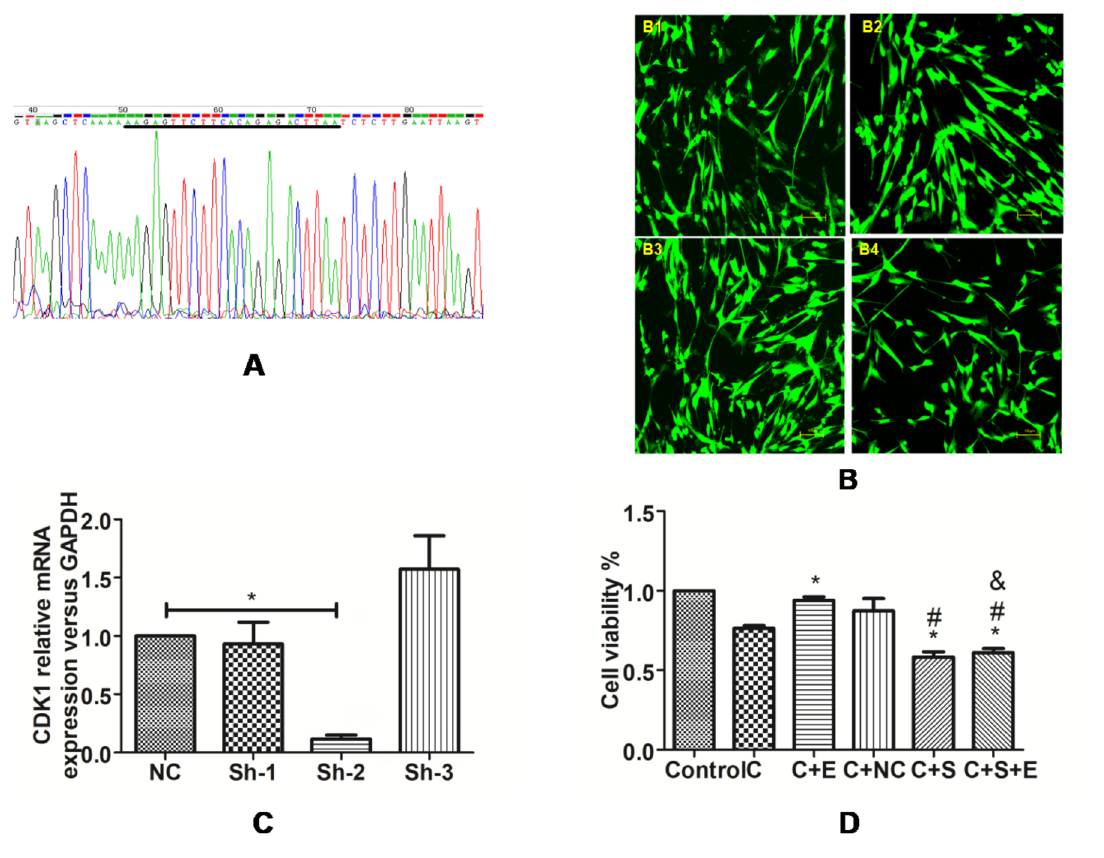
Figure 5 – Intervention of EPO on U251 cells under hypoxia through CDK1. (A) Partial sequencing of Sh-CDK1-2 (The part marked by black line is target sequence). (B) The expression of green fluorescent protein in each group: B-1, NC group; B-2, Sh-CDK1-1 group; B-3, Sh-CDK1-2 group; B-4, Sh-CDK1-3 group, 400*. (C) The interference effect of CDK1 interfering RNA eukaryotic expression vector under hypoxia environment.* P<0.05 vs. the NC group. (D) CCK-8 assay was used to detect the intervention effect of EPO on cells under hypoxia through CDK1.* P<0.05 vs. the CoC1 # P<0.05 vs. the CoC1 +NC group and & P<0.05 vs. the CoC1 +EPO group, Newman-Keuls multiple comparisons 2 2